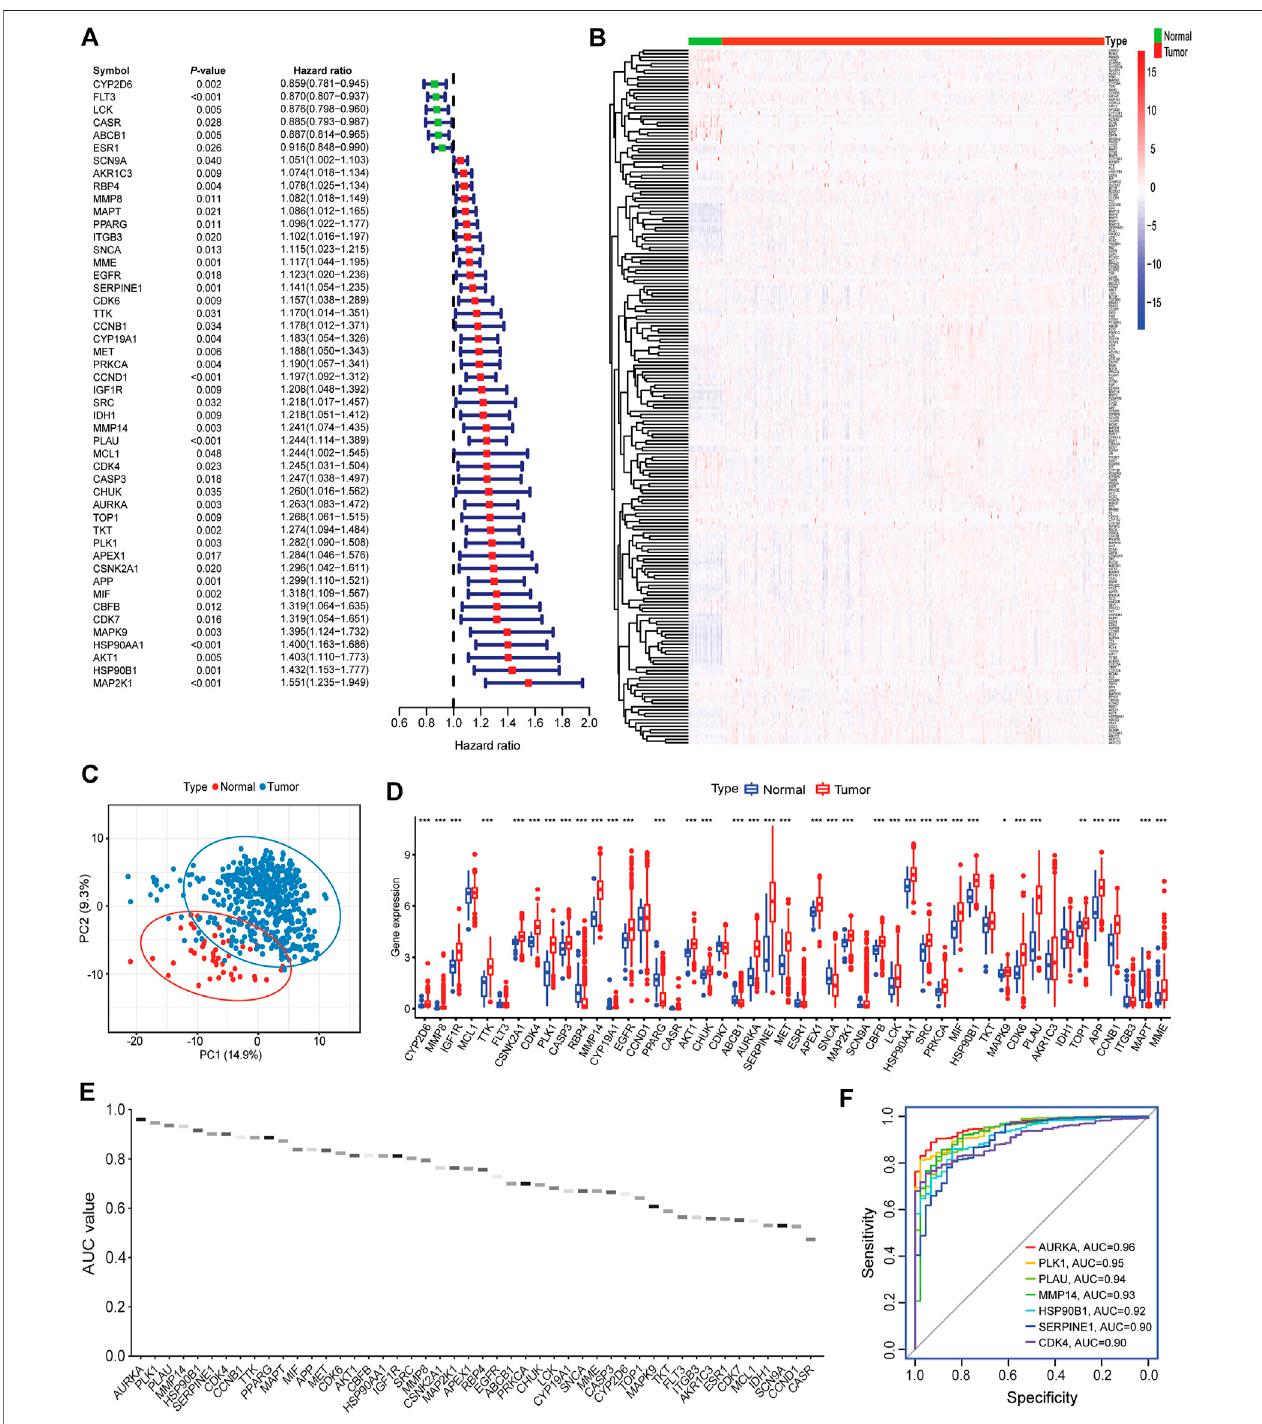
FIGURE 5 | Associations of intersecting targets with patients ’ outcomes, normal and tumor samples. (A) The forest plot represented the associations of intersecting targets with patients ’ outcomes. (B) Heatmap of intersecting targets expression in normal vs. tumor samples. (C) Principal component analysis showed a distinctexpression pattern ofintersecting targets innormalvs.tumor samples. (D) Expressionof48survival-relatedtargets innormalvs.tumor samples(Wilcoxtest, ***: < 0.001; **: < 0.01; and *: < 0.05). (E) AUC values of ROC analysis for 48 survival-related targets. (F) The top 7 targets that AUC values greater than 0.9.